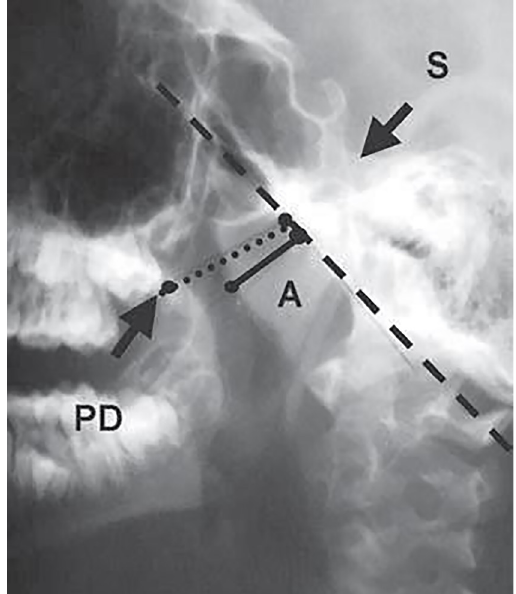
Figure 1 - Cavum X-Ray - adenoid nasopharynx ratio (ANR) – black line is the measure of the adenoid / dotted line is nasopharynx measure; ANR is the result of the division of the measures of the black line by the dotted line.